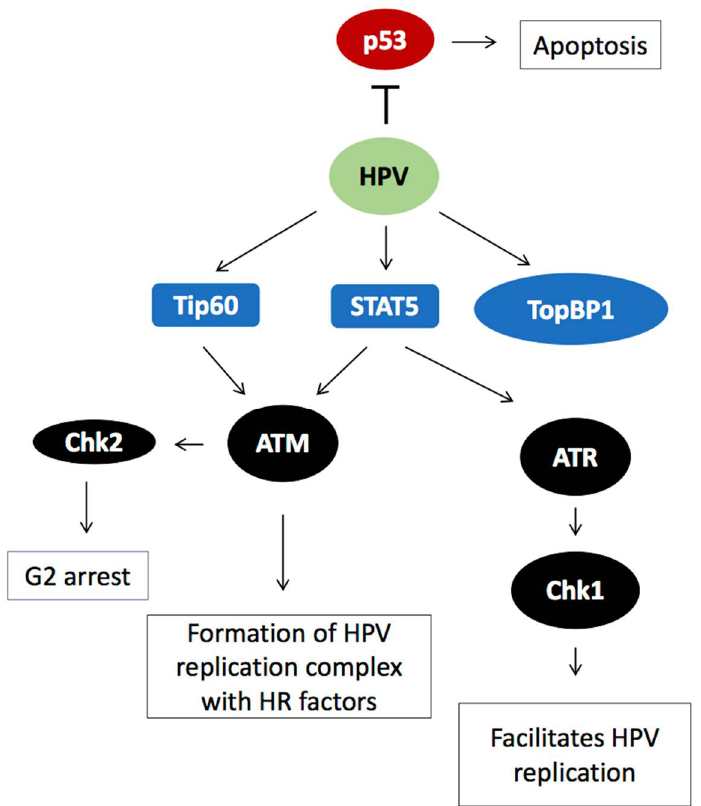
Figure 3. Interactions between HPV and the Ataxia-Telangiectasia Mutated (ATM) and ATM and Rad3-related (ATR) signalling during productive viral replication. HPV activates the ATM branch of the DDR to gain access to factors associated with homologous recombination. This activation occurs at least partially through the Tip60 acetyltransferase and signal transducer 5 (STAT5) that are both required for activation of ATM. In addition, the ATR branch of the DDR is activated by HPV. HPV replication foci contain TOPBP1, a protein necessary for ATR activation. The exact mechanism of ATR activation is unclear Downstream of ATM/ATR signal transduction are the kinases Chk1 and Chk2, both of which have been found in HPV replication foci and are known to be crucial for cell cycle arrest and regulation of genes needed for HPV genome amplification. To counteract the potential induction of apoptosis by the cellular DDR, HPV E6 targets p53 for degradation to inhibit apoptosis.